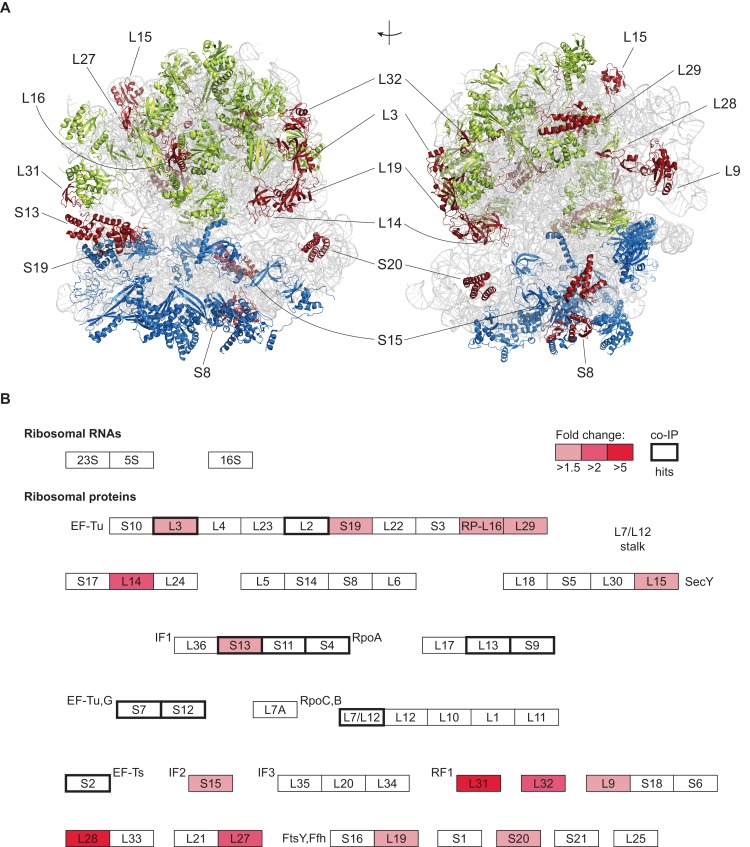
Ribosomal proteins accumulating in the cpa-knockout cells during starvation mapped onto the structure of the 70S mycobacterial ribosome.(A) Proteins colored green belong to the 50S subunit of the ribosome, while the blue ones belong to the 30S subunit. Red color indicates proteins that accumulated in the cpa-knockout strain during carbon starvation. For clarity, rRNA is shown in semi-transparent grey cartoon representation. The figure was generated using the recent structure of the 70S ribosome from M. smegmatis (PDB: 5O61, (Hentschel et al., 2017)). (B) Depiction of accumulating ribosomal proteins (red) in the context of the KEGG pathway map for the assembled ribosome (Kanehisa et al., 2016). Boxes framed in bold represent proteins identified in at least two out of three replicates of the co-immunoprecipitation experiment.